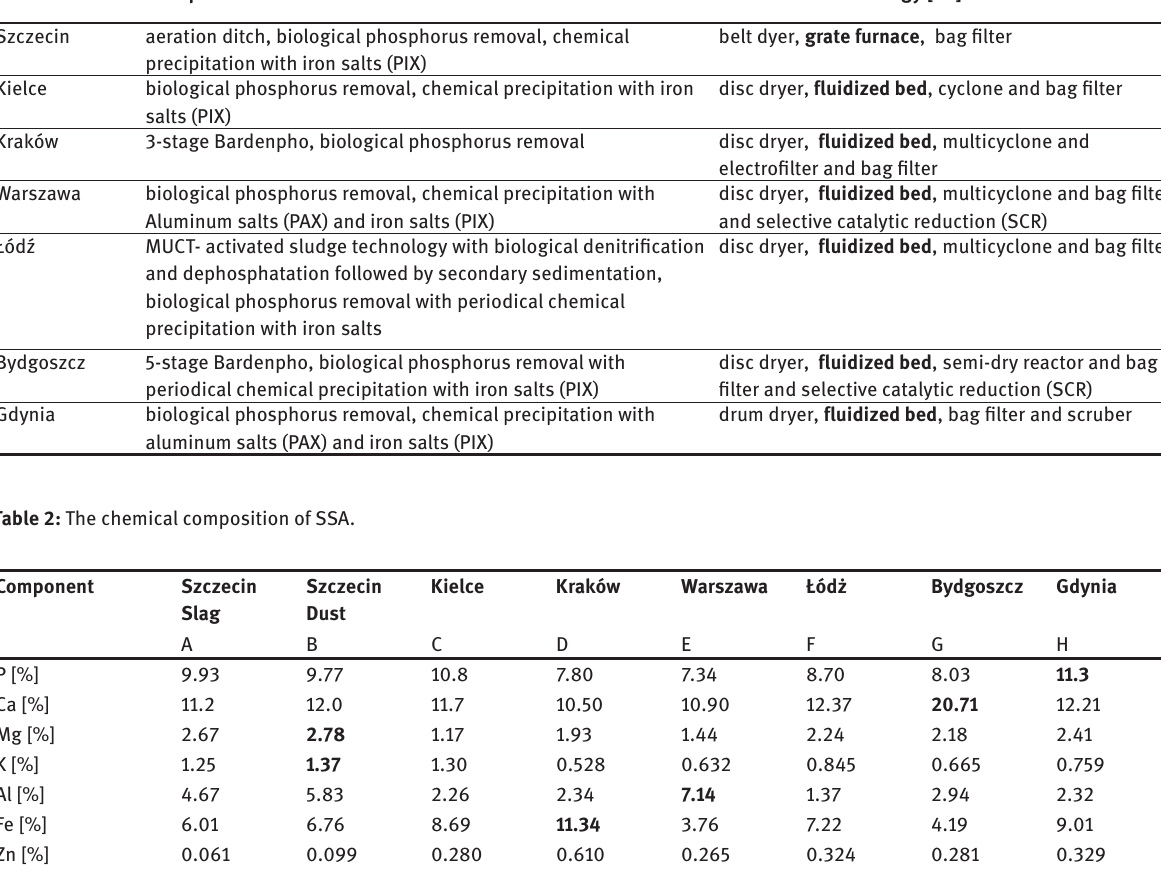
Table 1: The characteristic of the phosphorus removal method from sewage and combustion technology of sewage sludge (technological data from each plant, 2012). Location